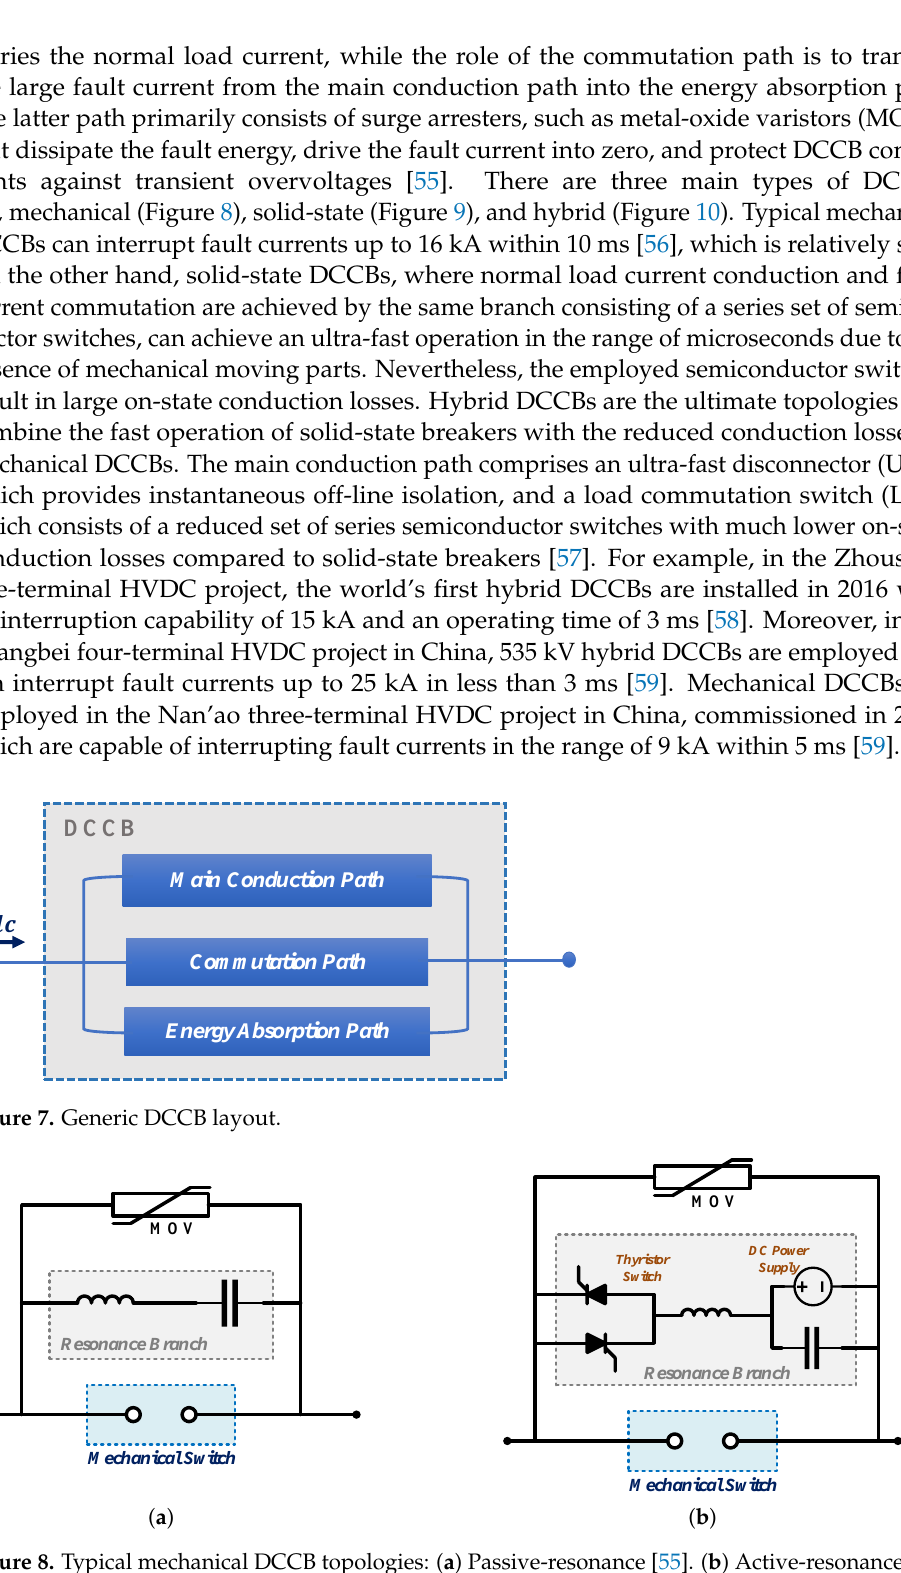
Figure 8. Typical mechanical DCCB topologies: ( a ) Passive-resonance [55]. ( b ) Active-resonance